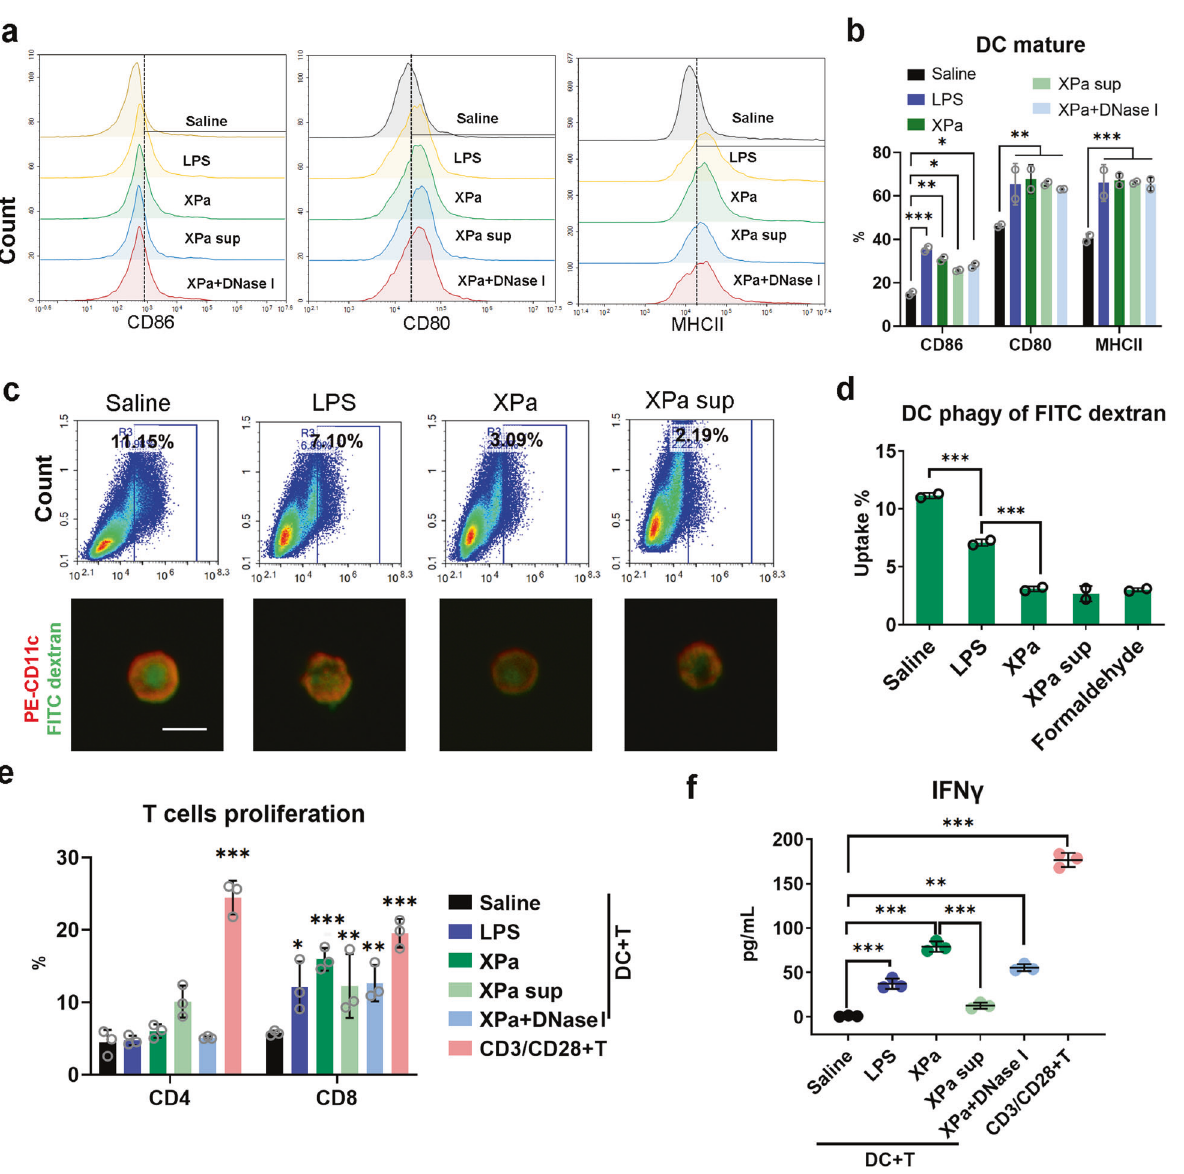
Fig. 2 Effect of XPa on DC functions. a and b DC maturation. DCs were stimulated with saline, XPa (10 MOI) and LPS (100 ng), XPa sup (same volume of XPa), and XPa + DNase I (10 MOI) for 24 h, and then collected for fl ow cytometry analysis. b The percentages of CD86 + , CD80 + , and MHCII + among CD11c + cells. c Uptake of FITC – dextran by BMDCs subjected to the different treatments. Scale bar = 50 μ m. d Data analysis of c . e The stimulated DCs (saline; XPa (10 MOI) and LPS (100 ng); XPa sup (same volume as XPa) and XPa + DNase I (10 MOI) for 24 h) were cocultured with the CFSE-stained T cells at a ratio of 1:10 after 72 h, with CD3/CD28 as a positive control. * indicates signi fi cant from the saline control. f The IFN- γ concentration in the culture medium. Data were analyzed via two-way ANOVA. No letter is present if no signi fi cant difference was observed. * P < 0.05, ** P < 0.01, *** P <